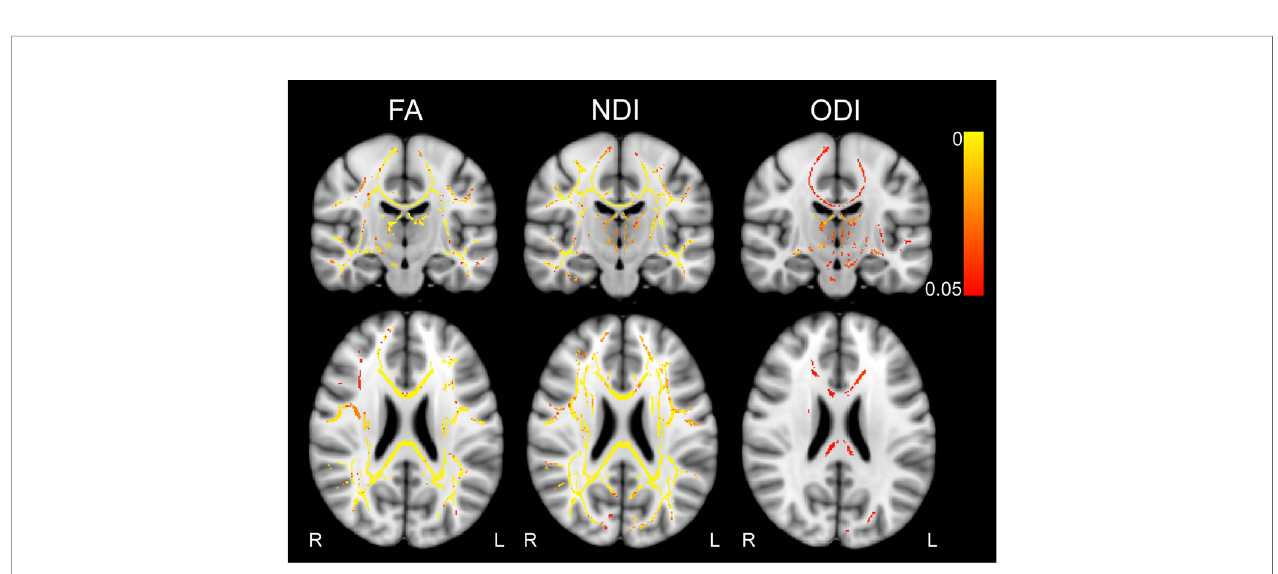
FIGURE 4 | Results of tract-based spatial statistics analyses. Color bar indicates TFCE-corrected p-value, thresholded at p <.05. Contrast HC > MS for FA and NDI, and MS > HC for ODI. MNI coordinates: x = 90, y = 109, z = 95. FA, fractional anisotropy, NDI, neurite density index, ODI, orientation dispersion index, L, left, R, right, TFCE, threshold-free cluster enhancement.